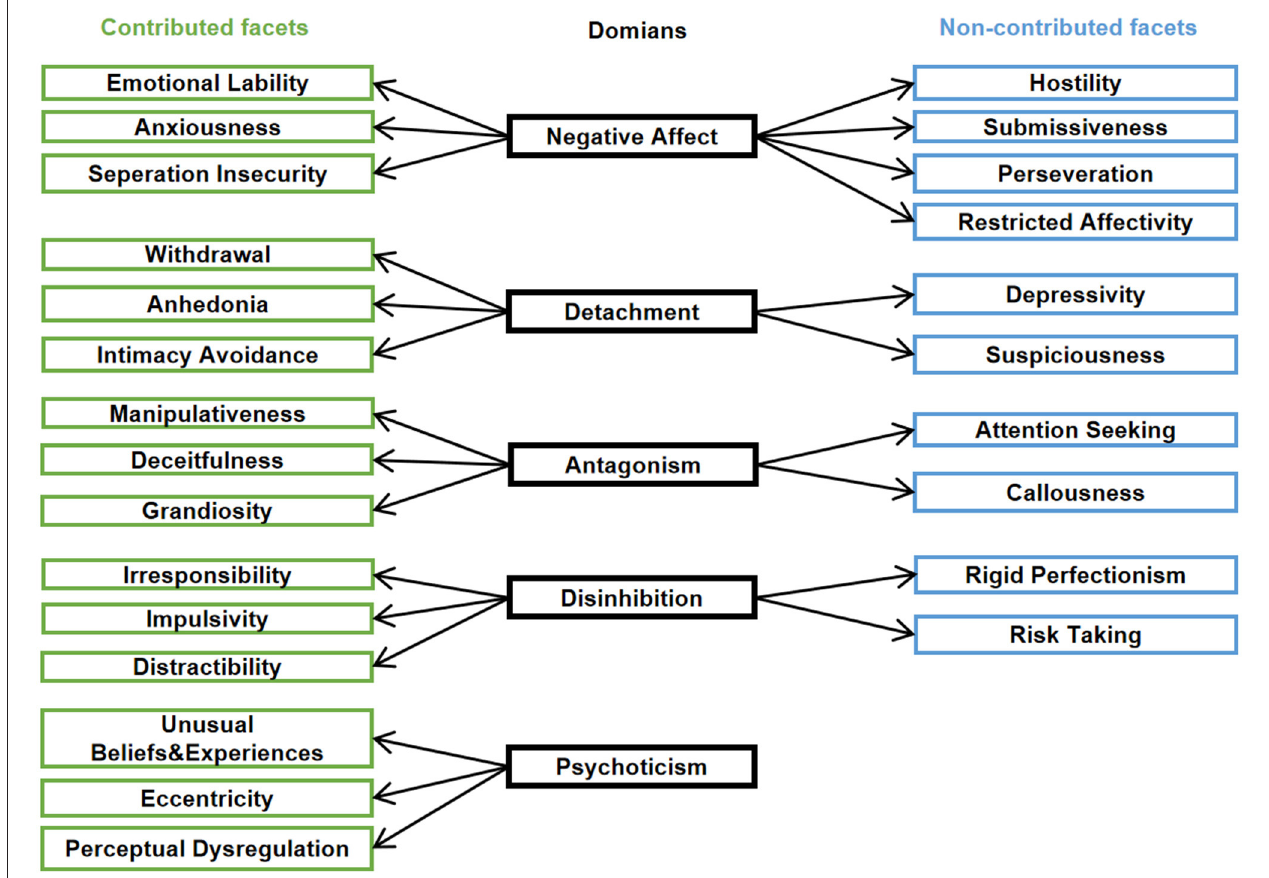
FIGURE 1 | The PID-5 structure. The domains are shown in the middle column, with contributed facets on the left (green) and non-contributed facets (blue) on the right,